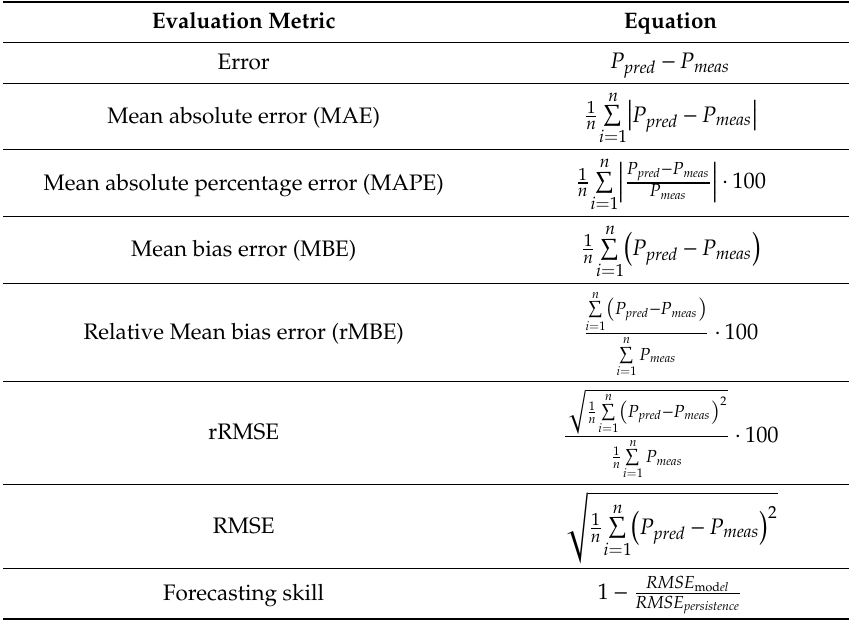
Table 2. Evaluation metrics.